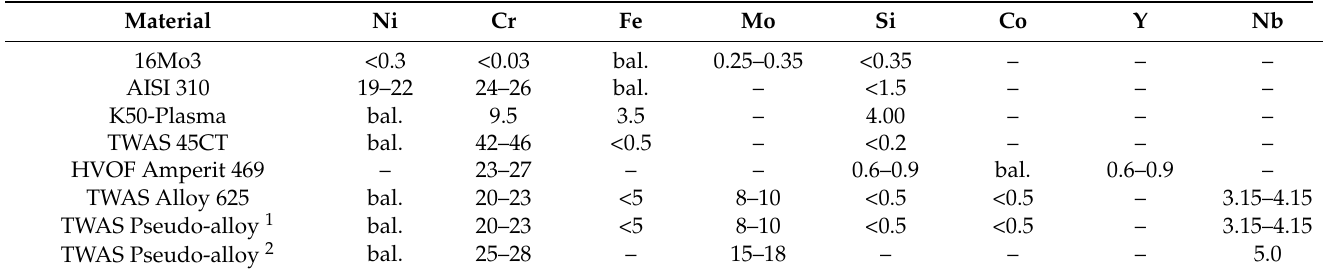
Table 1. Chemical composition of the coating precursors and base materials